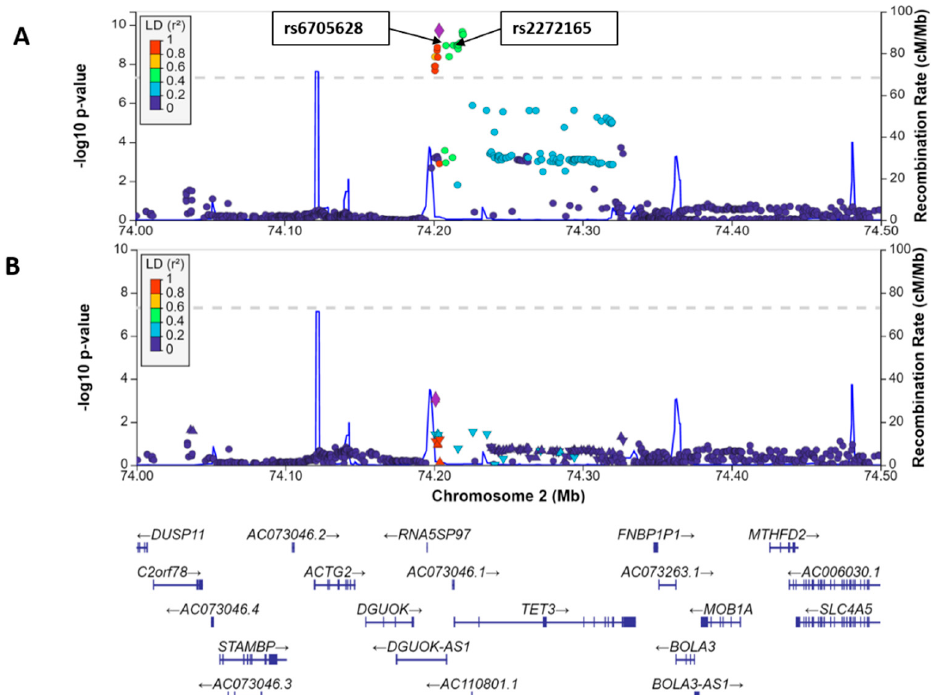
Figure 2. Ethnicity-specific meta-analysis, conditional analysis, and bioinformatics. ( A ) Plot shows − log 10 p -value from the Asian cohorts on the left y -axis and physical position on the x -axis. The SNPs selected for conditional analysis are shown in boxes. Dots identify individual SNP p -values, colored by their LD strength (r 2 ) with the lead SNP. Blue line indicates pre-calculated recombination rates (in cM/Mb, right y-axis) at each position. ( B ) SNP association after conditional analysis with the two selected SNPs.